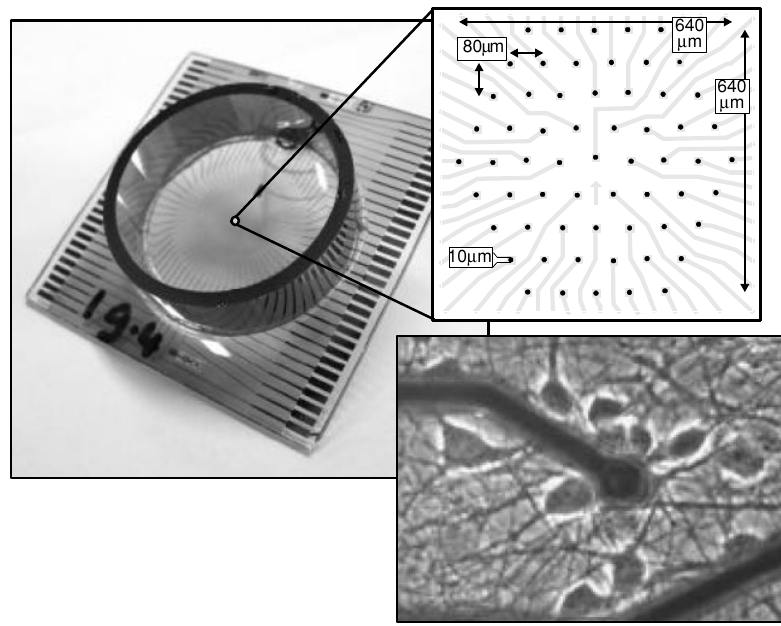
Figure 2 Multielectrode array device with culture dish (diameter 30 mm) on top. The MEA is based on a glass substrate (5 cm × 5 cm), and it has 61 embedded electrodes. The 61 electrode tips (tip diameter 10 µ m) lie in the center of the chamber (magnified in right top of figure). The figure right below shows a detail of one tip, surrounded by a 4 DIV old developing cortical cell